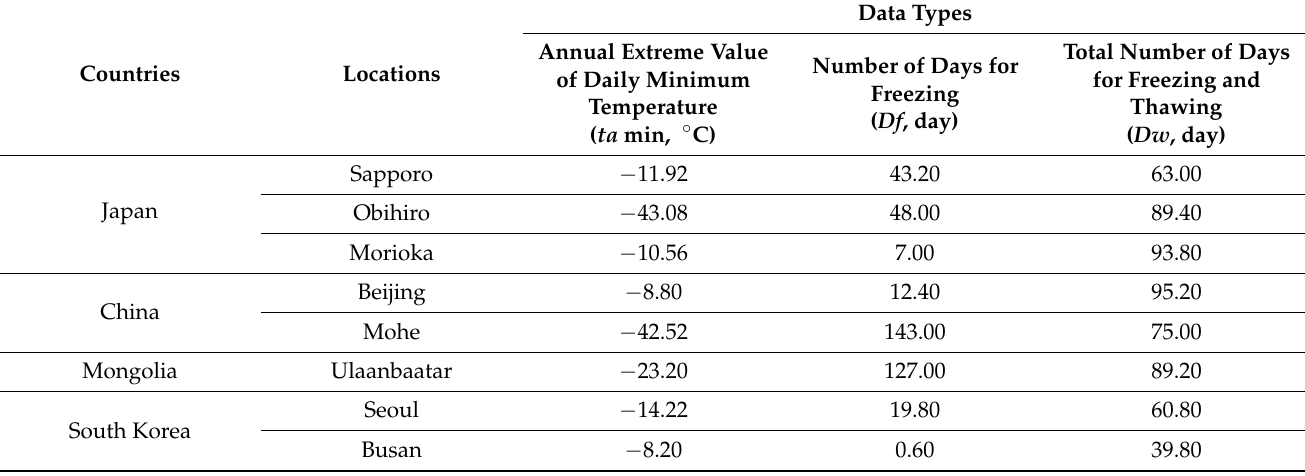
Table 8. Calculation results of winter meteorological data of various